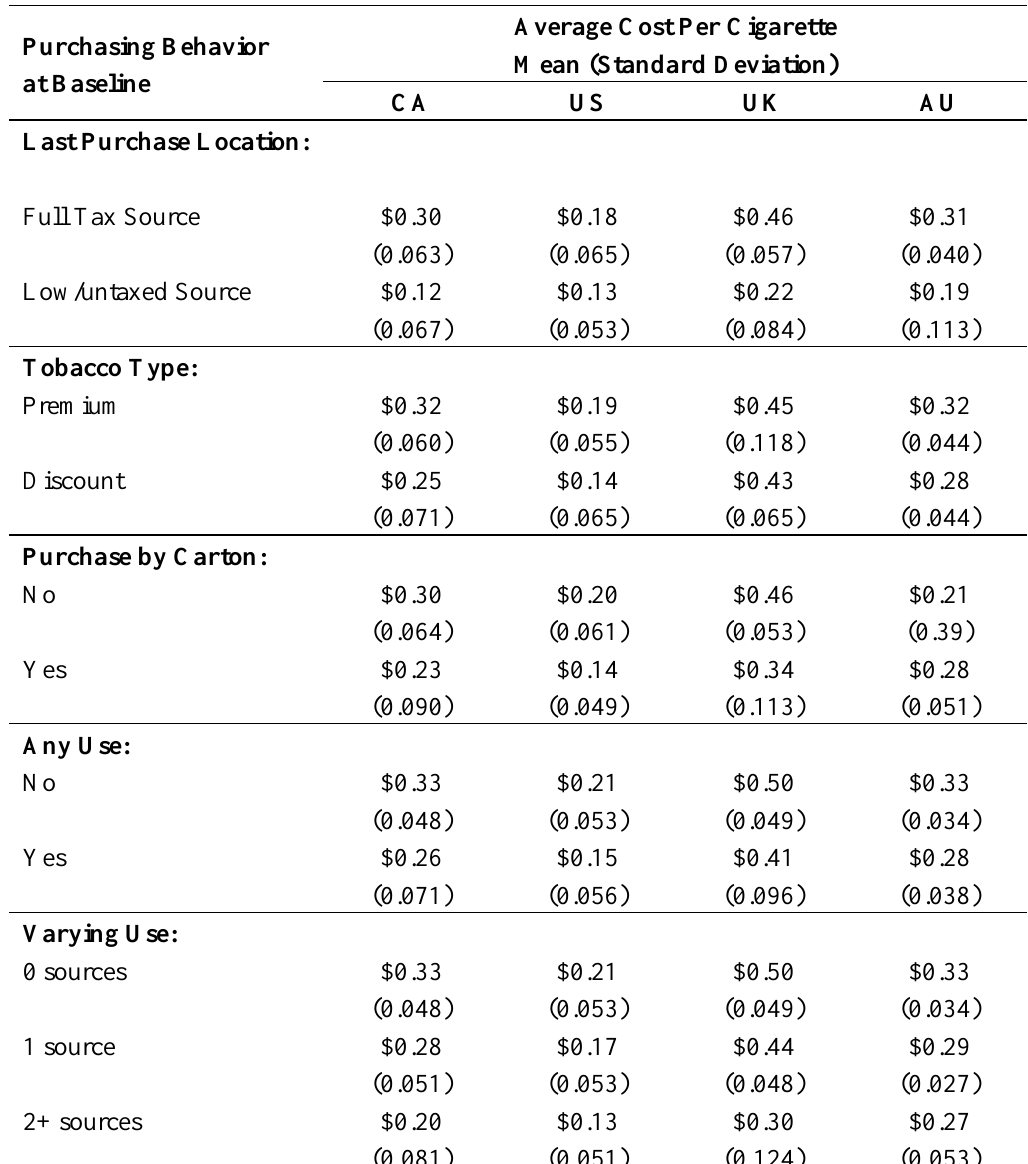
Table 2. Mean price per cigarette for various price/tax avoidance behaviors, stratified by